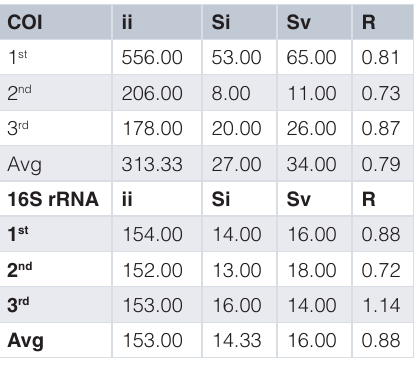
Table 3. Directional (16 pairs) nucleotide substitution rate for COI and 16S rRNA genes. All frequencies are average (rounded) over all taxa. ii = identical pairs, Si = transitional pairs, Sv = tranversional pairs, R = Si/Sv and Avg = average.